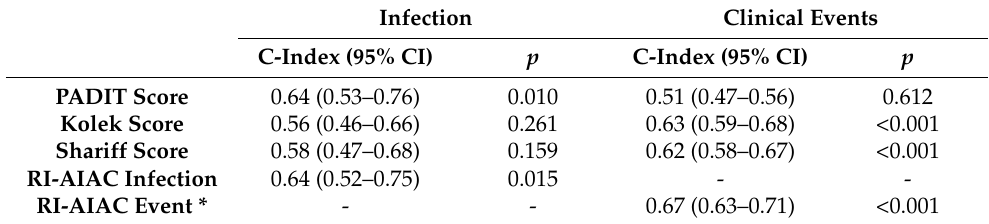
Table 5. Predictive ability of clinical scores.